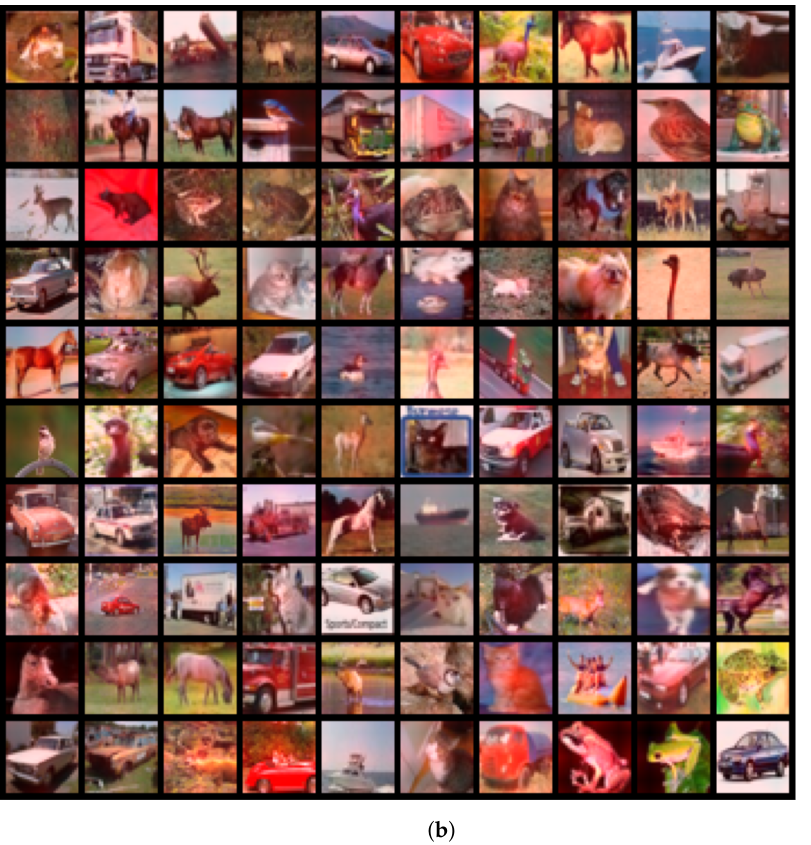
Figure 1. Detection of ( a ) locally concentrated novelty and localization on the MVTec dataset and ( b ) global anomalies on the CIFAR-10 dataset. All shown examples are from the outlier test set and the red color highlights the location of the novelty in the images. The overlayed red score map is computed using the µ shift anomaly score (cf. Equation (11)) without applying the spatial max-operator, such that the model output is a 2D grid of anomaly scores. These scores are mapped to a red heat map and resized to match the input resolution using bilinear interpolation. Hence, red areas correspond to potentially anomalous